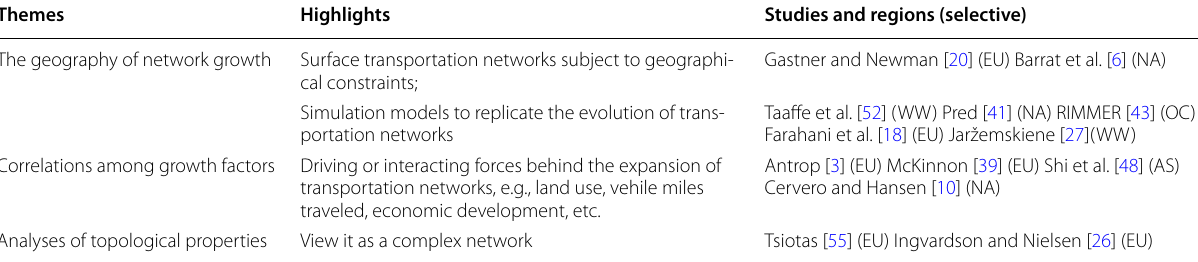
AS—Asia; EU—Europe; NA—North America; OC—Oceania; WW—worldwide